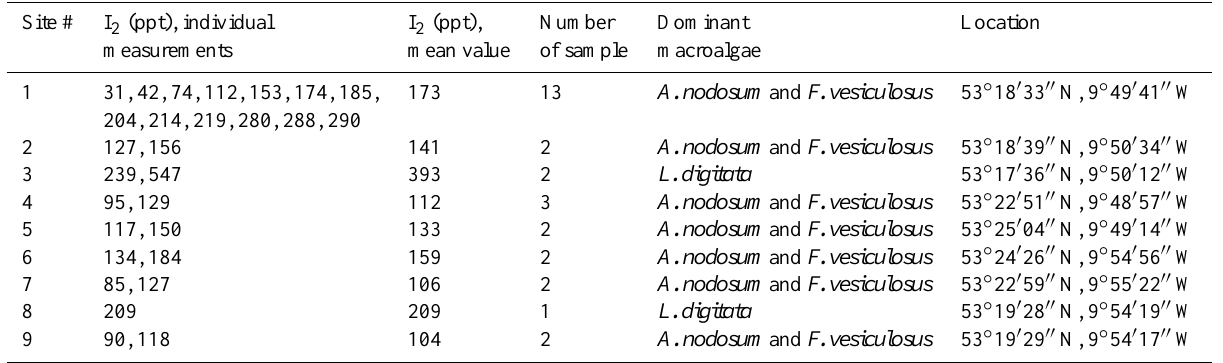
Table 1. The mixing ratio of I 2 at different sites on the west coast of Ireland. Site